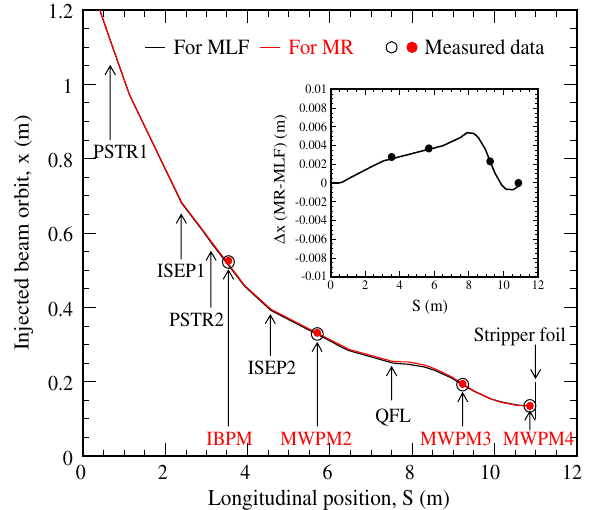
FIG. 7. A comparison of the calculated (black and red lines) and measured (open and solid circles) injected beam orbits for the MLF ( 150 (cid:1) mm mrad ) and MR ( 100 (cid:1) mm mrad ) painting, respectively. The horizontal axis is the longitudinal position along the RCS central orbit, where the vertical axis is the horizontal position of the injected beam with respect to the RCS central orbit. The difference of the two orbits is shown in the inset. The measured beam position for both MLF and MR painting orbits as well as the difference of the two orbits are found to be quite consistent with the expected ones produced by the numerical